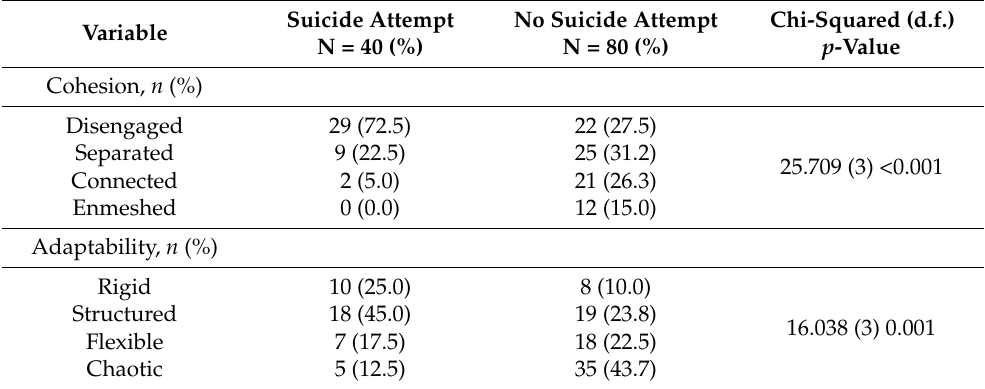
Table 3. Comparison of family sub-types according to adaptability and cohesion in both groups.